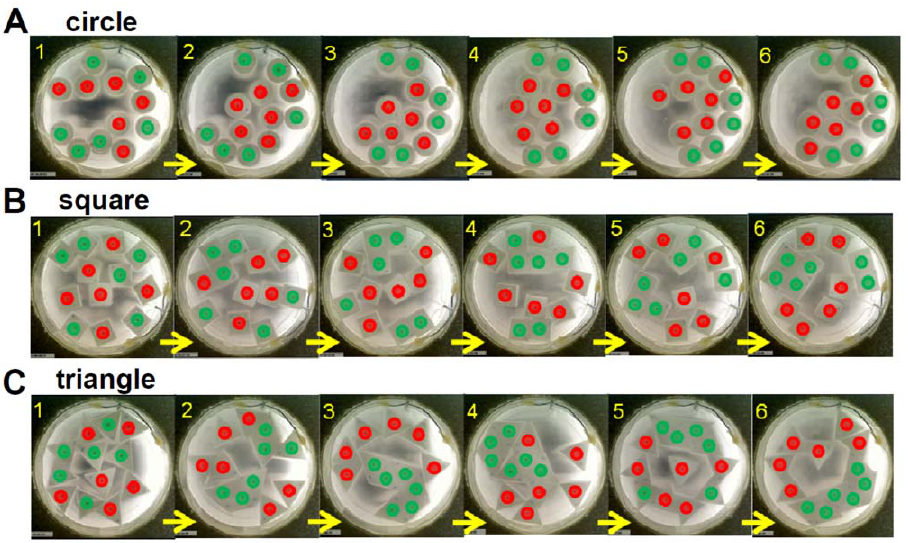
Figure 2. Typical behavior of elements in the circular, square, and triangular cases. A. Observation durations of 1. 8.9 s , 2. 13.3 s , 3. 52.8 s , 4. 77.3 s , 5. 112.8 s , and 6. 121.2 s are shown. B. Observation durations of 1. 8.8 s , 2. 27.4 s , 3. 53.1 s , 4. 93.8 s , 5. 125.5 s , and 6. 142.2 s are shown. C. Observation durations of 1. 8.3 s , 2. 44.3 s , 3. 56.2 s , 4. 69.4 s , 5. 93.6 s , and 6. 160.0 s are shown. The colors of the elements are emphasized for clarity. See also Video. S1 for the typical behavior in the circular, square, and triangular cases. The initial configuration of the elements was set as similarly as possible among all shapes (See Materials and Methods section).